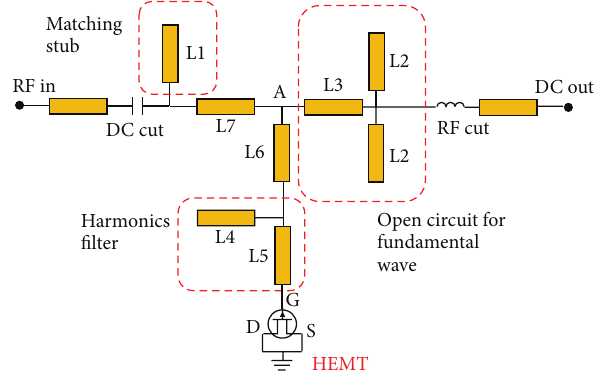
Figure 3: Circuit diagram of a basic design of the C-band rectifier using HEMT